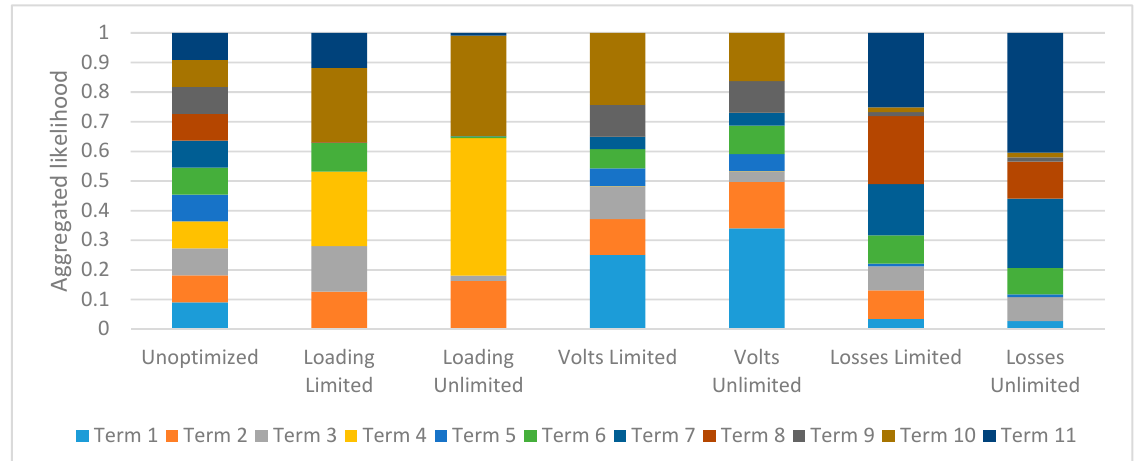
Figure 10. Aggregated likelihood of new EV being plugged into a terminal when optimized for associated cost reduction.